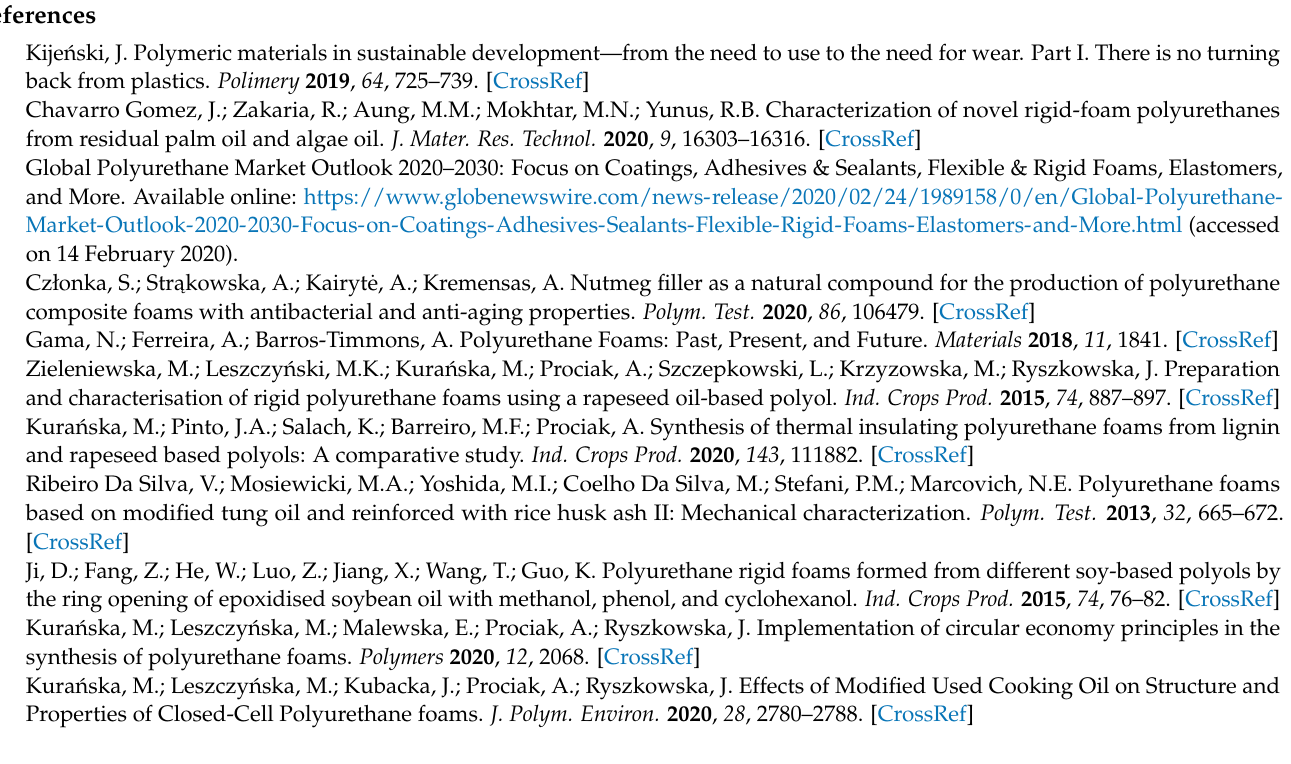
oil-based polyol, Figure S2: Results of the closed cell content analysis in PU_REF and PU_ROP_25- 100 foams, Figure S3: TG and DTG thermograms of the rigid polyurethane foams with rapeseed oil-based polyol, Figure S4: DSC curves (C2) of the rigid polyurethane foams with rapeseed oil-based polyol, Figure S5: SEM images filler particles in the foams with rapeseed oil-based polyol and natural fillers, Table S1: The composition of rigid polyurethane foams, Table S2: The results of the thermogravimetric analysis, Table S3: The results of the DSC curve analysis of the rigid polyurethane foams with rapeseed oil-based polyol, Table S4: Apparent density, friability, dimensional stability and water absorption of the foams with rapeseed oil-based polyol, Table S5: Specific compressive strength of the foams with rapeseed oil-based polyol and natural